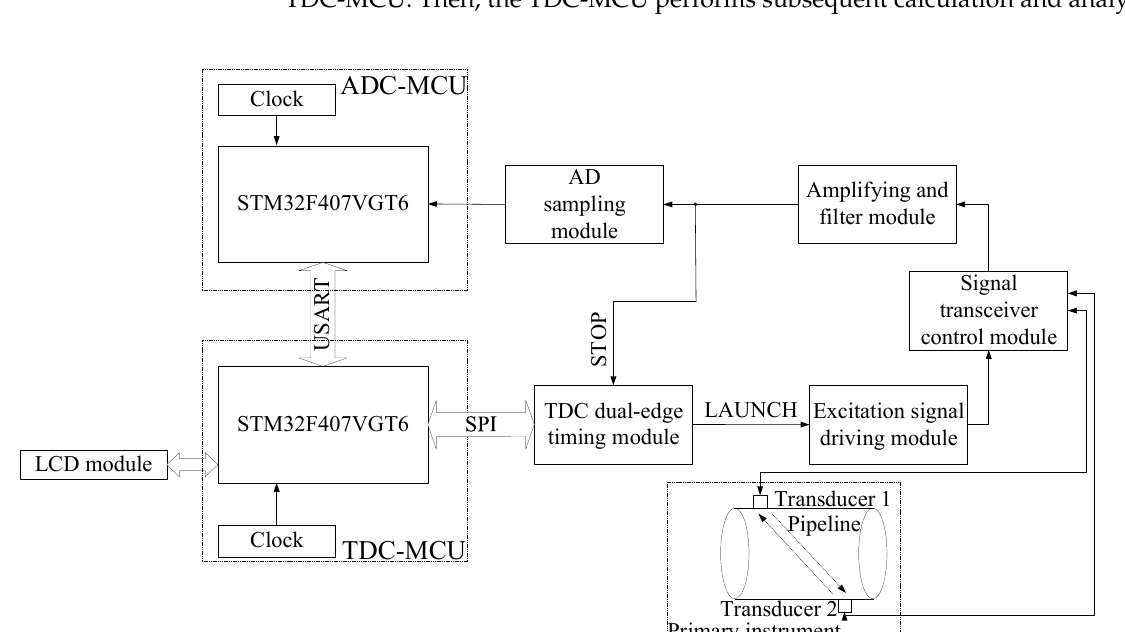
Figure 8. Diagram of the hardware of the ultrasonic flowmeter.